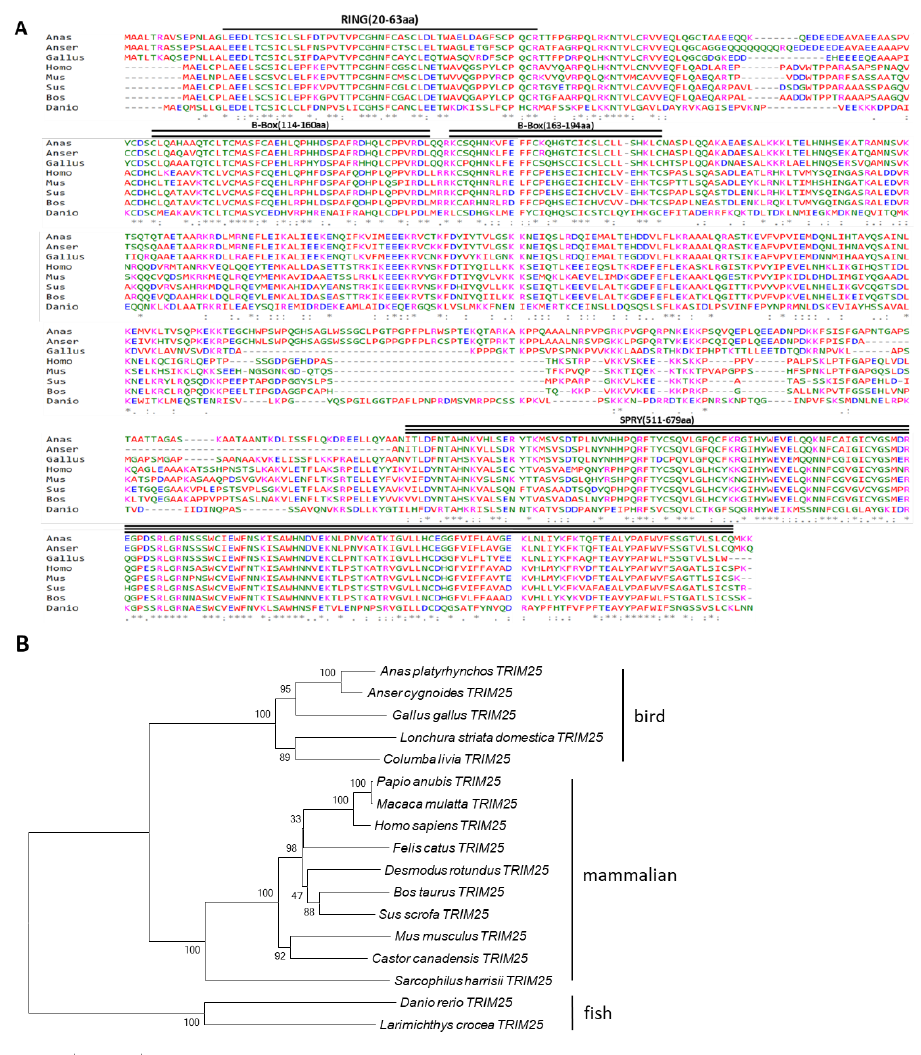
Figure 1. ( A ) Multiple alignments of TRIM25 protein sequences from duck (KY974316), goose (XP_047920213), chicken (NP_001305387.1), human (NP_005073.2), mouse (NP_033572.2), cattle (NP_001093806.1), pig (XP_005657028.3) and zebrafish (NP_956469.1). The symbol ‘*’ denotes 100% conserved residues, ‘:’ and ‘.’ represent relatively conservative residues, spaces represent non-conservative residues and ‘–’ indicates gaps during alignment. ( B ) A phylogenetic tree of the TRIM25 amino acid sequences was constructed by the neighbor-joining tree method using MEGA version 6. The sequence of each species was obtained from NCBI Genbank. The bar indicates the bootstrap value (%).